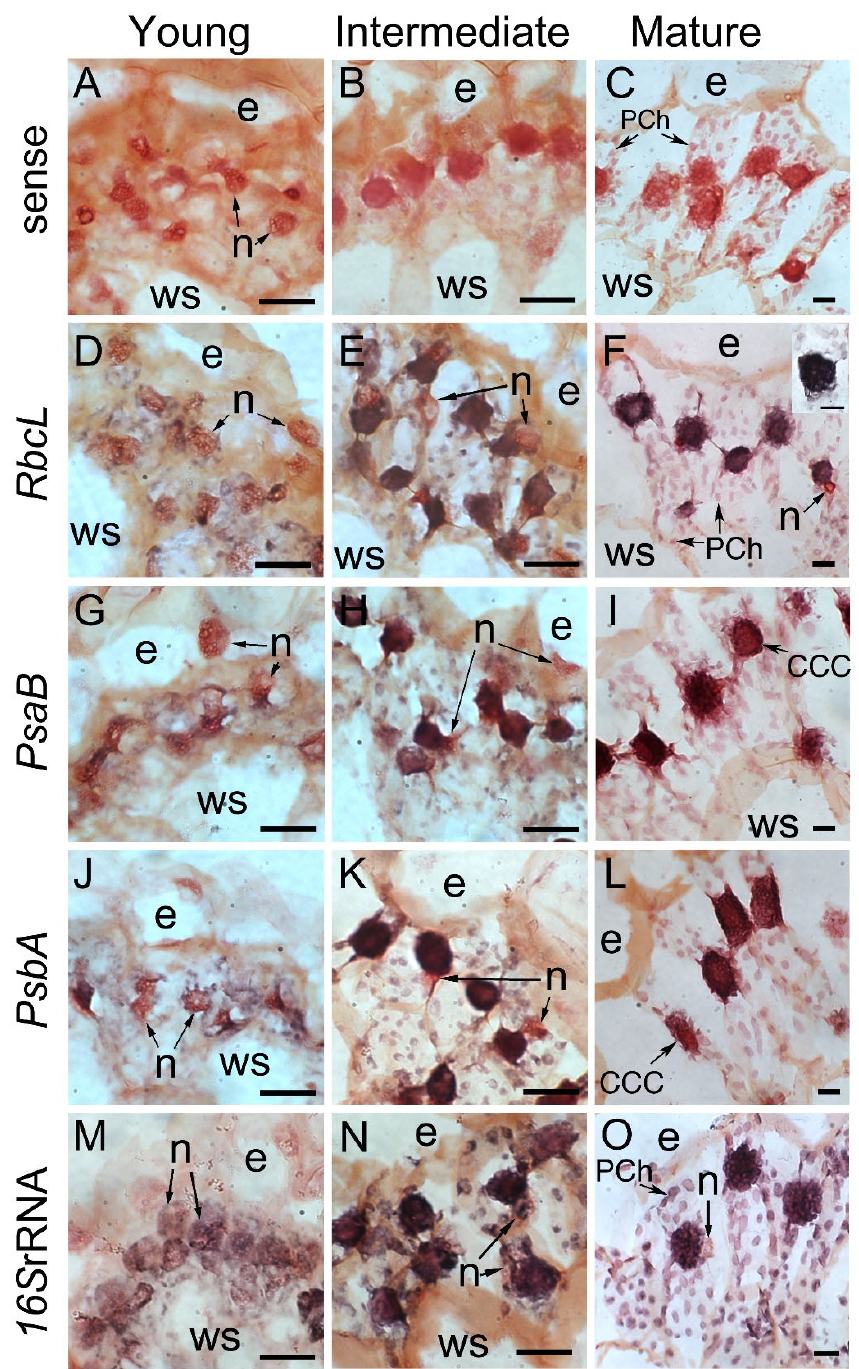
Figure 6. Chloroplastic transcript localization in chlorenchyma cells of developing B. sinuspersici leaves. Sections were prepared from shoot tips and mature leaves. Images are enlarged images of leaves at three developmental stages: ( A , D , G , J , M ) young, ( B , E , H , K , N ) intermediate, and ( C , F , I , L , O ) mature. Cross ‐ sections were hybridized with labelled ( A – C ) sense rbcL or ( D – F ) antisense rbcL , ( G – I ) psaB , ( J – L ) psbA , or ( M – O ) 16S RNA probes. Sections were counter ‐ stained with Safranin O for the better visualization of cellular structures except for the inset image in ( F ). Individual chlorenchyma cells are outlined by a dashed line ( A – C ). Specific hybridization is shown in purple. CCC, central cytoplasmic compartment; PCh, chloroplasts in the peripheral cytoplasmic compartment (PCC); e, epidermal cells; ws, water storage cells; n, nuclei; rbcL , Rubisco large subunit. Scale bars = 20 μ m.